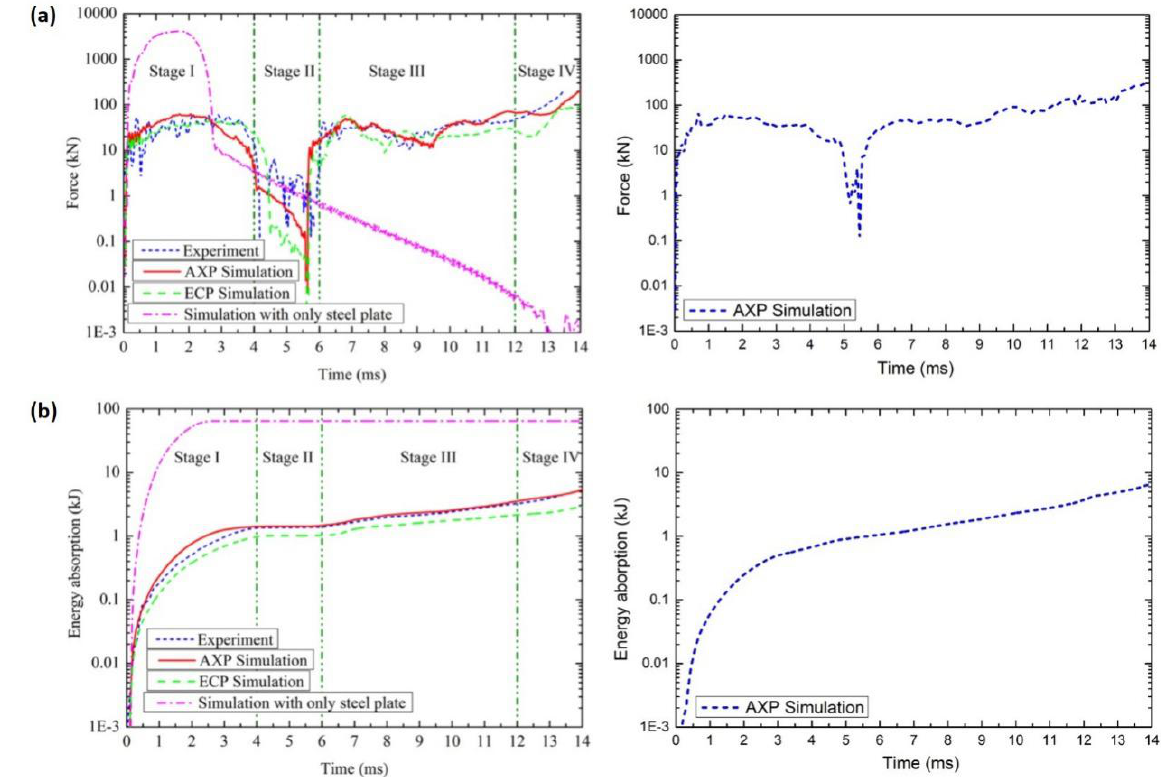
Figure 5: Comparison of impact histories between experimental and numerical results [34]: (a) Impact force; (b) Energy absorption. (AXP (auxetic honeycomb panel), ECP (equivalent conventional honeycomb